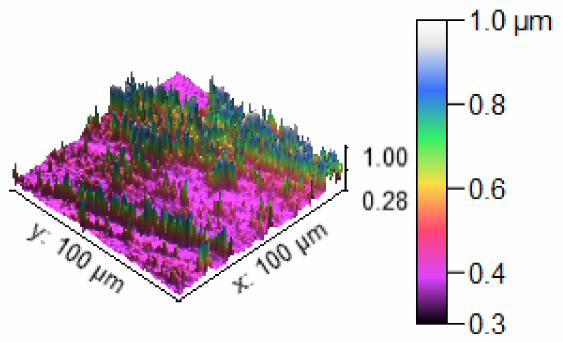
Figure 19. Three dimensional (3D) profilometric image